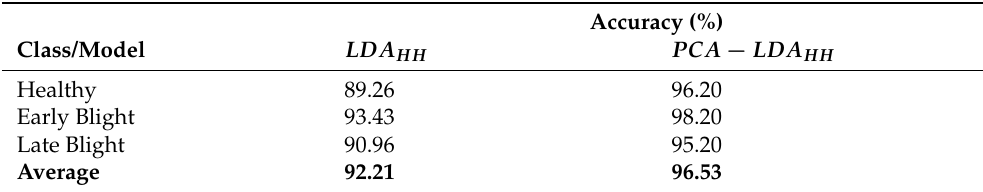
Table 1. Classification accuracy of handcrafted hybrid (HH)-features-based models for potato leaf disease identification.